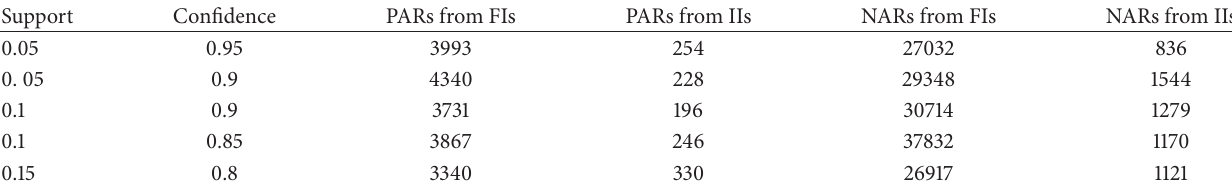
Table 3: Positive and negative association rules using varying support and confidence values.